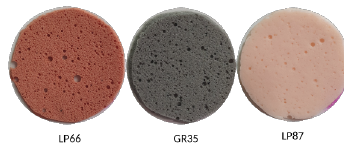
Figure 2. Photography of the polyurethane fi lms